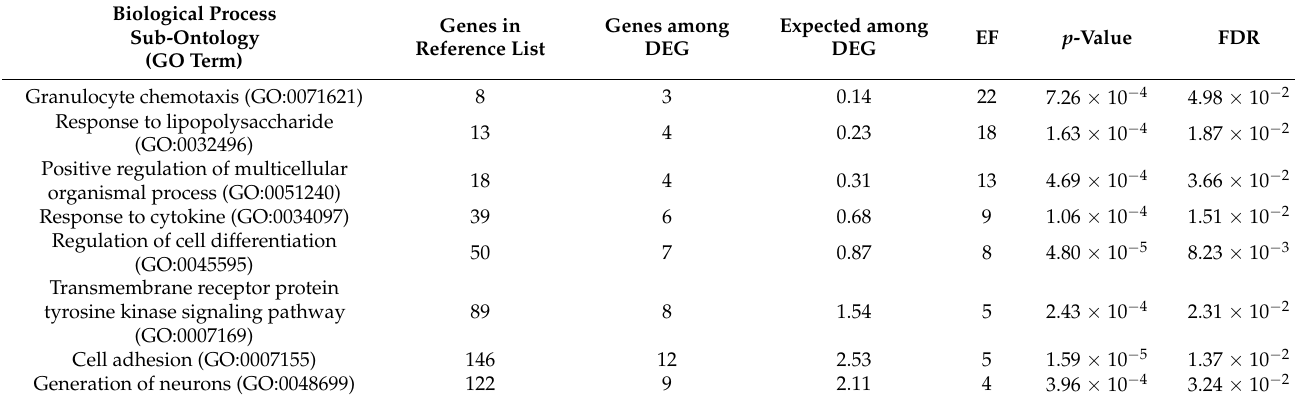
Table 4. The slim biological process ontology terms overrepresented in the differentially expressed genes in the T98G human glioblastoma exposed for 72 h to 20 µ g/mL of TiO 2 -NPs. Only the results for FDR p < 0.05 are displayed. DEG = differentially expressed genes, EF = enrichment factor, GO = Gene Ontology and FDR = false discovery rate. Biological Process Sub-Ontology